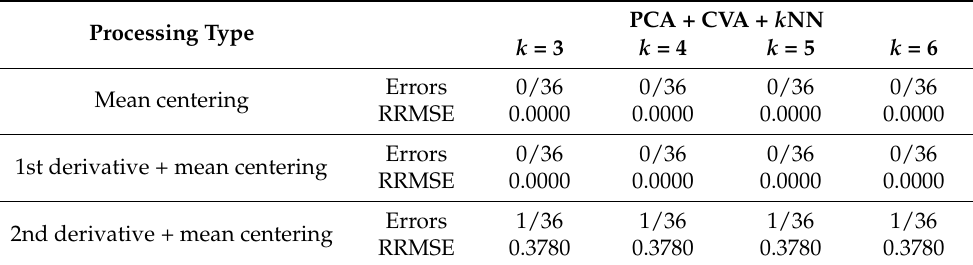
Table 8. Study No. 2 with Combined NIR + MIR Spectral Data. Prediction-Set Classification Errors (36 Samples).